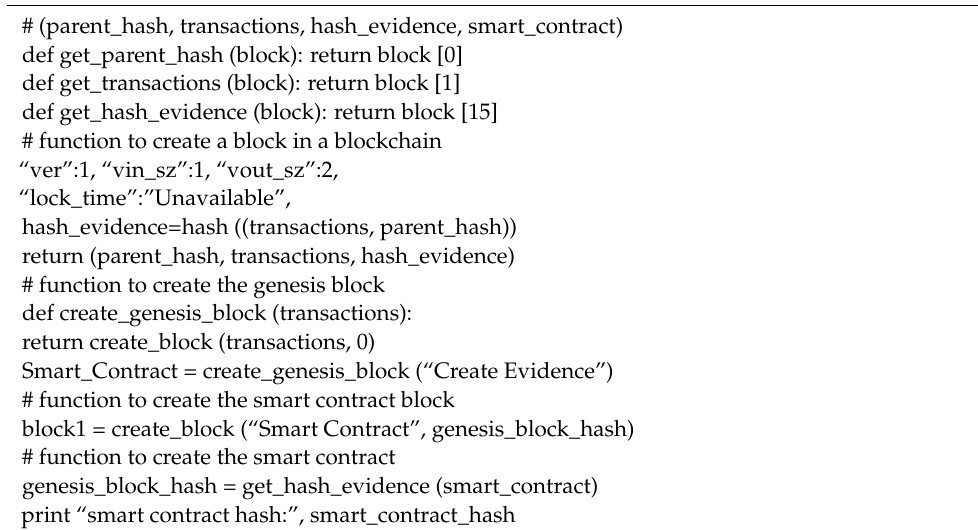
Algorithm 1. Custody